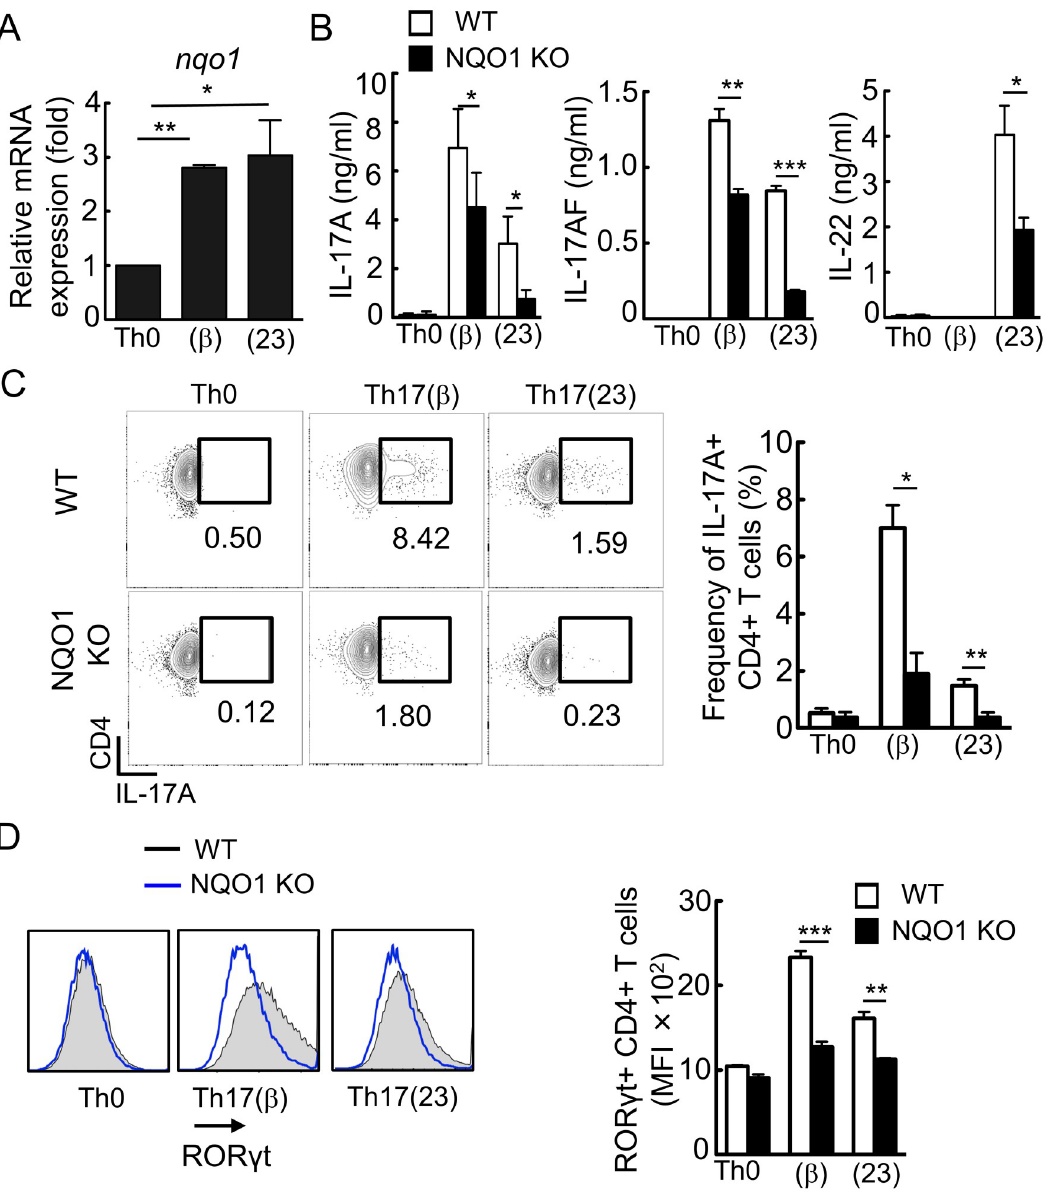
Fig 1. NQO1 promotes Th17 differentiation in vitro . Isolated CD4 + CD62L hi na ï ve T cells were stimulated with anti-CD3 (2 μ g/ml) and anti-CD28 (2 μ g/ml) antibodies and cultured with Th17( β ) (stimulated with IL-6 +TGF β ) and Th17(23) (stimulated with IL-1 β +IL-6 +IL-23) skewing conditions for 3 days. (A) Real-time PCR analysis of Nqo1 gene expression in WT (n = 3). (B) IL-17A and IL- 22 production in the cell culture supernatant was measured by ELISA. (n = 5) (C) On days 3, the differentiated cells were stimulated with PMA, Ionomycin, and BFA for 4 h. The plot indicates frequencies of CD4 + IL-17A + T cells (n = 3). (D) Histogram showing internal staining of CD4 + ROR γ t + expression (n = 3). Each graph indicates the mean ± SE, One way